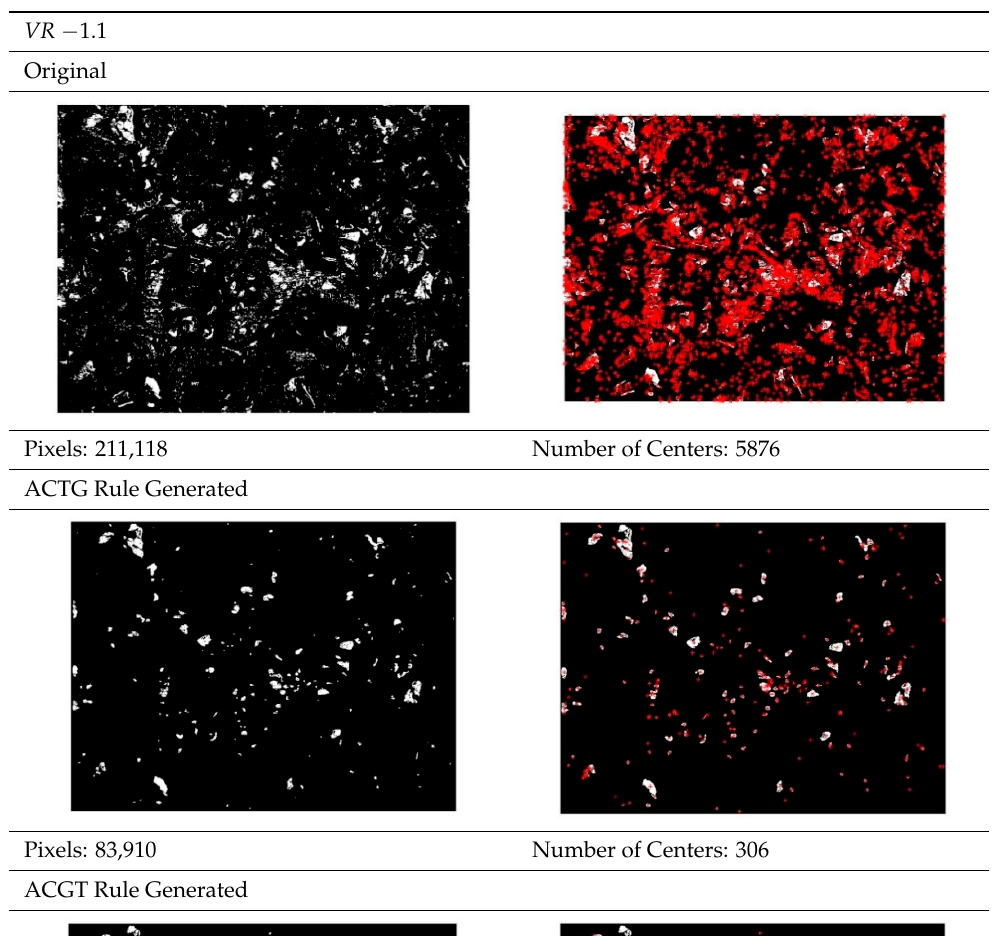
Table A9 . Images and associated pixels and number of centers corresponding to VR = − 1.1.